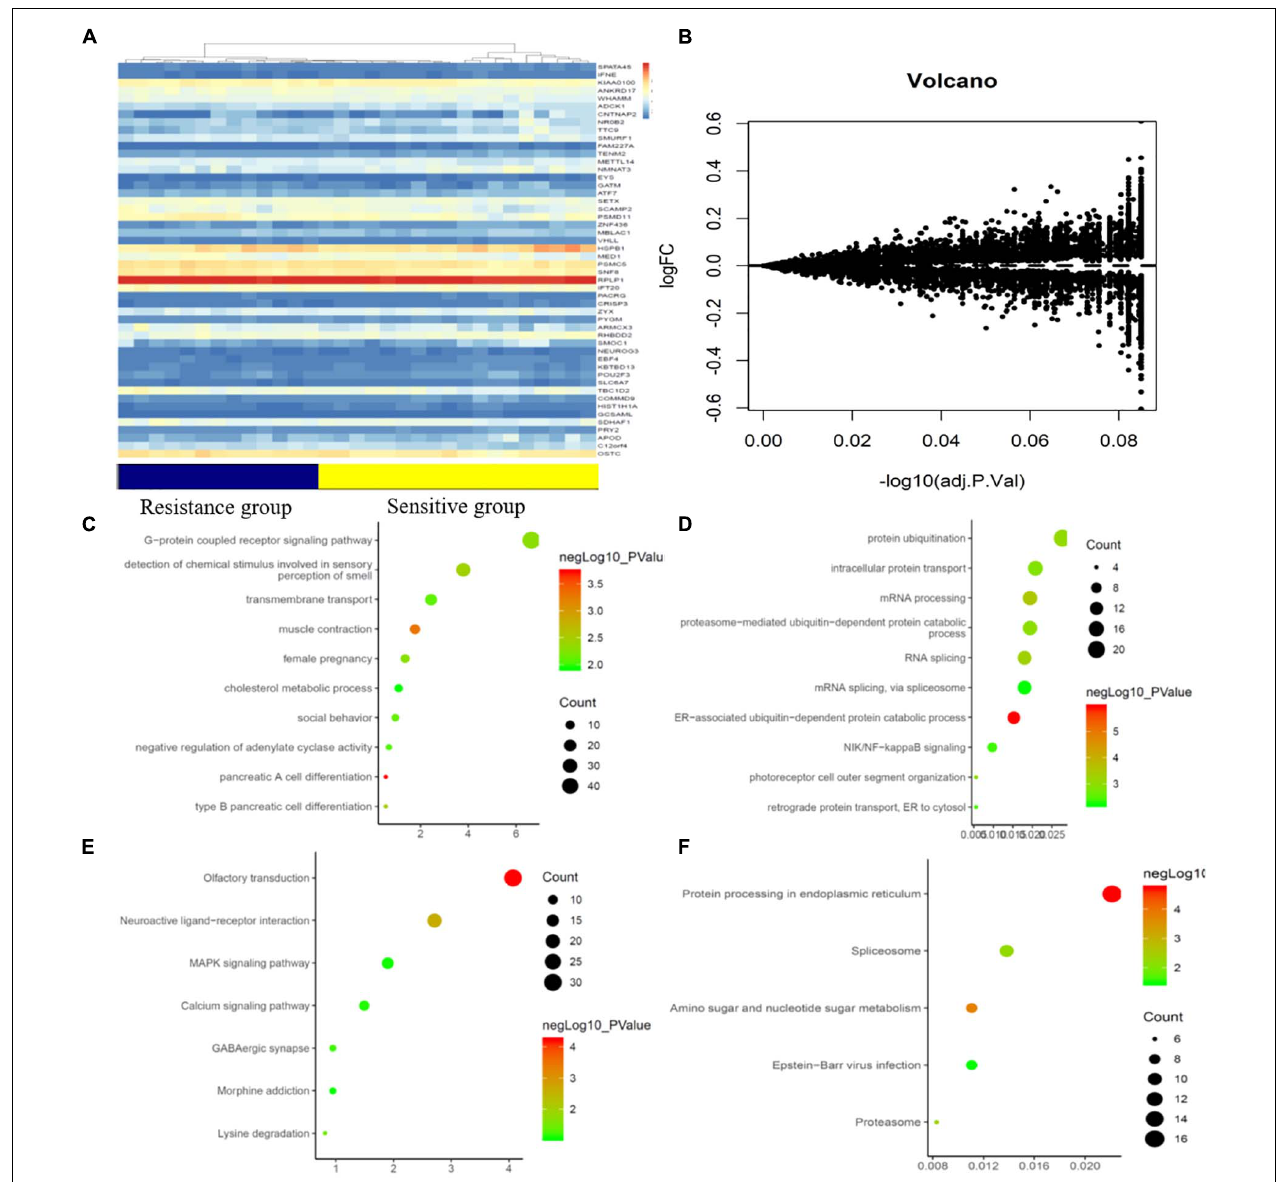
FIGURE 2 | mRNAs expression profile comparison between chemotherapy-resistance and chemotherapy-sensitivity groups. Gene Ontology (GO) functional and Kyoto Encyclopedia of Genes and Genomes (KEGG) pathway analysis of the differentially expressed genes. (A) The hierarchical clustering of all targets values of mRNA expression profiling among samples. (B) Between the chemotherapy-resistance and chemotherapy-sensitivity group. The purple dots indicated the up-regulated genes of mRNAs and the green dots indicated the down-regulated genes of mRNAs. (C) GO functional analysis of the top ten functional classifications of the upregulated genes. (D) GO functional analysis of the top ten functional classifications of the downregulated genes. (E) KEGG pathway analysis of the top ten significant pathways of upregulated genes. (F) KEGG pathway analysis of the top ten pathways of downregulated